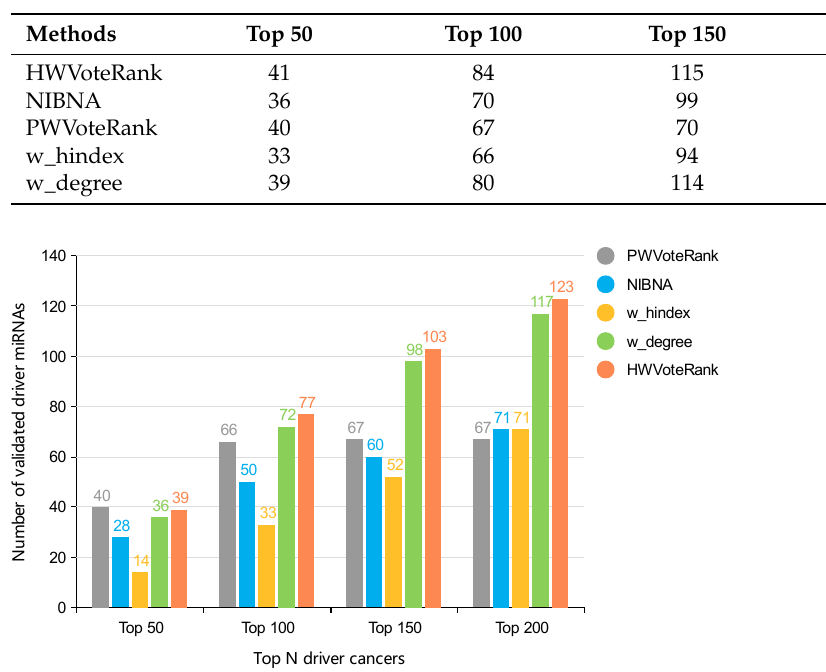
Figure 3. Comparison of the number of confirmed miRNA drivers in the top 200 predicted cancer drivers, excluding genes without mutations.